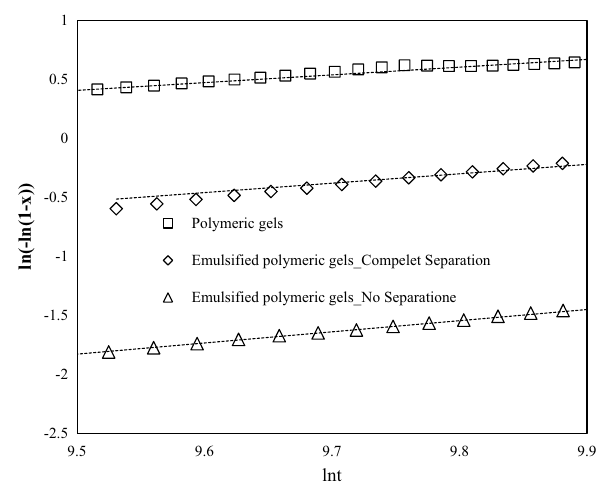
Fig. 14 Avrami’s model for the isothermal